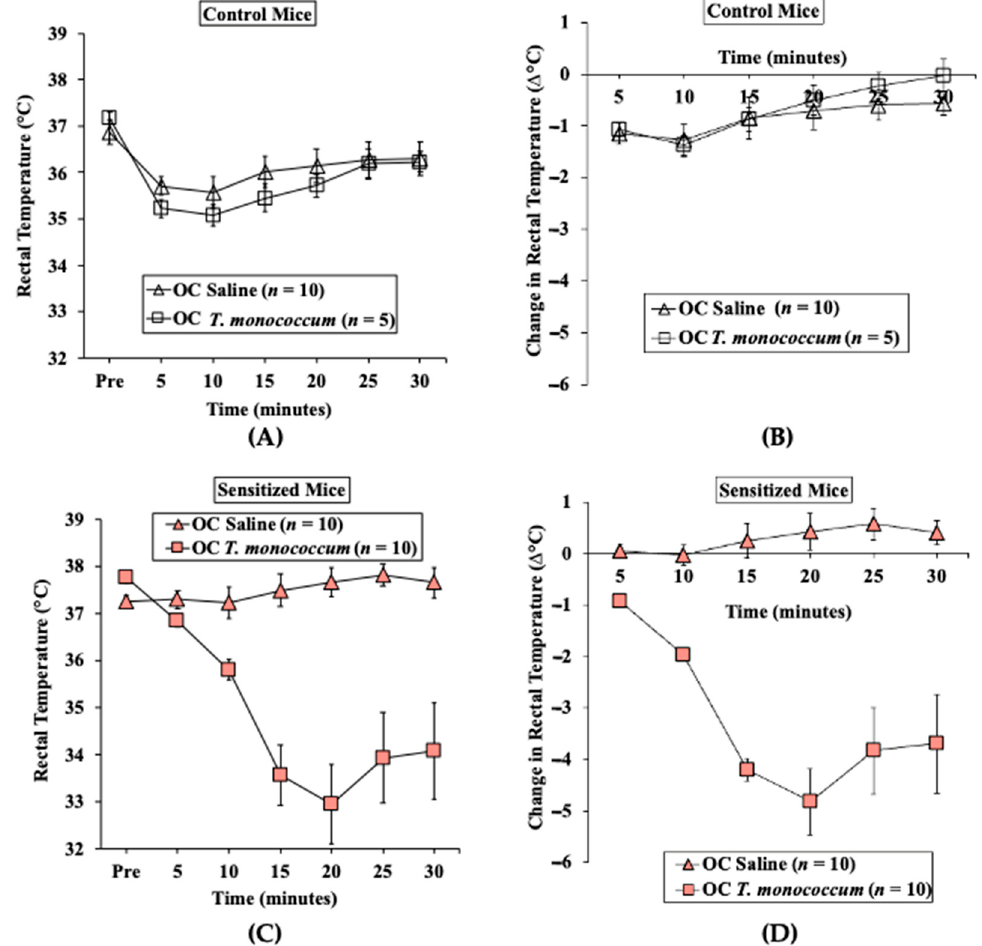
Figure 2. Transdermal sensitization with SSPE is sufficient for eliciting oral anaphylaxis using Triticum monococcum (genome AA) SSPE in Balb/c mice. Mice were sensitized and orally challenged with T. monococcum SSPE or saline, as described in Materials and Methods. ( A ) Actual rectal temperature at indicated time points in control mice challenged with T. monococcum SSPE or saline. ( B ) Change in rectal temperature at indicated time points in control mice challenged with T. monococcum SSPE or saline. ( C ) Actual rectal temperature at indicated time points in SSPE-sensitized mice challenged with T. monococcum SSPE or saline. ( D ) Change in rectal temperature at indicated time points in SSPE-sensitized mice challenged with T. monococcum SSPE or saline. OC: oral challenge, SSPE: salt-soluble protein extract, n : number of mice,